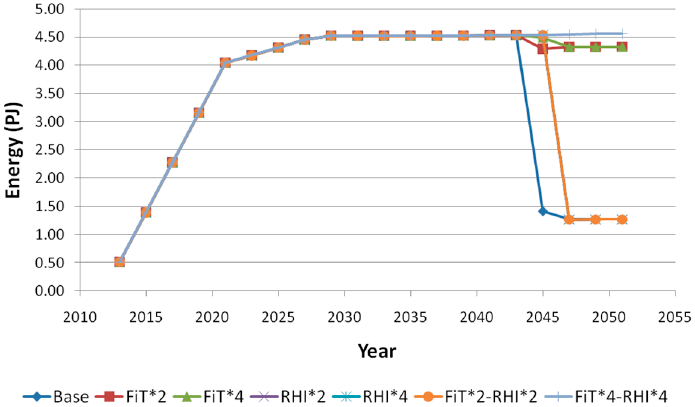
Figure 8. Dairy farms—biogas production.